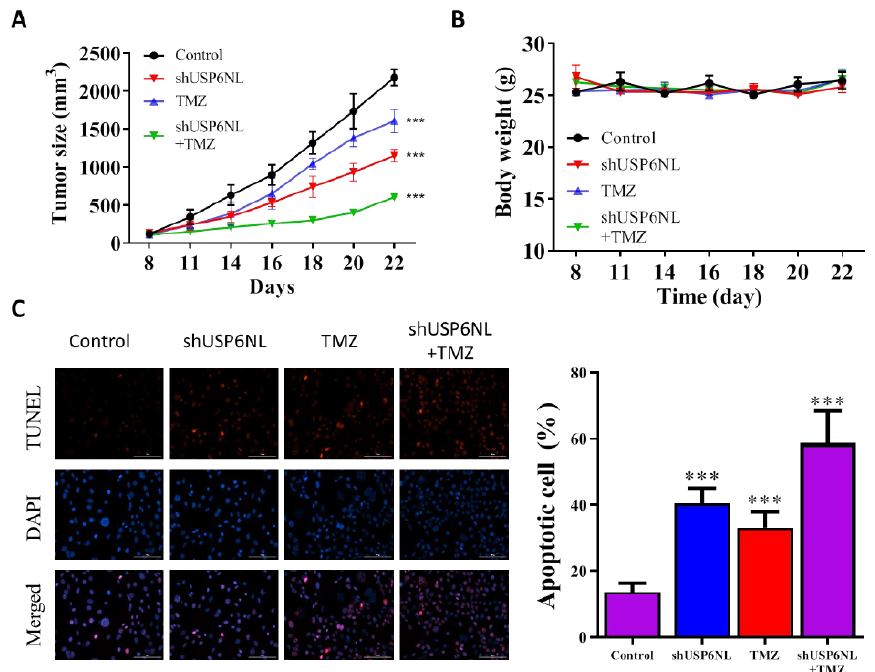
Figure 7. USP6NL-knockdown suppressed tumorigenicity of T98G GBM cells in nude mice. ( A ) Time course of control and shUSP6NL tumor volume progression, as measured using a caliper. ( B